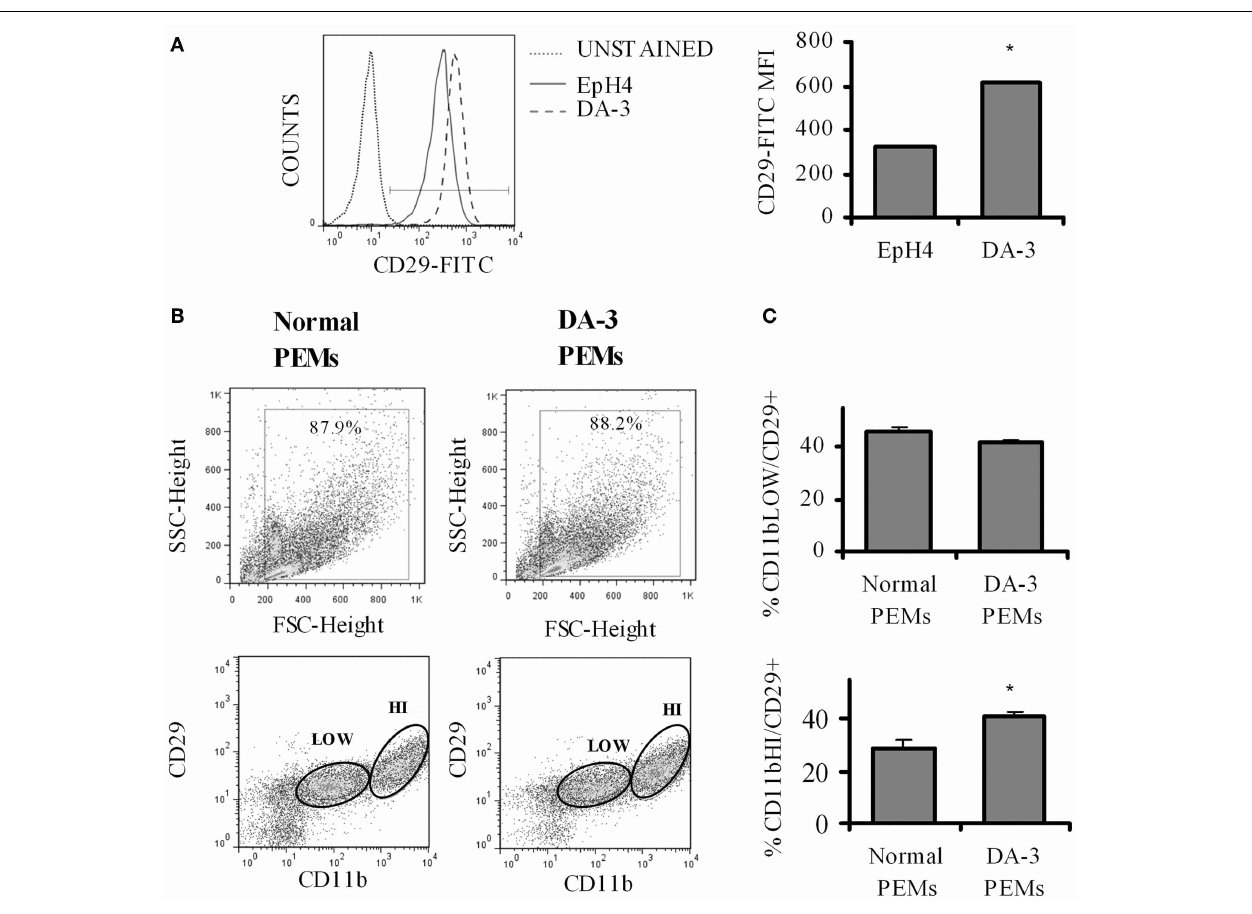
FIGURE 2 | β 1 integrin expression is increased in DA-3 cells and macrophages of mammary tumor-bearing mice. (A) Flow cytometric analysis of DA-3 mammary tumor cells and EpH4 mammary epithelial cells for the expression of β 1 integrin (CD29) (a representative plot of 2 independent experiments); (B) scatter